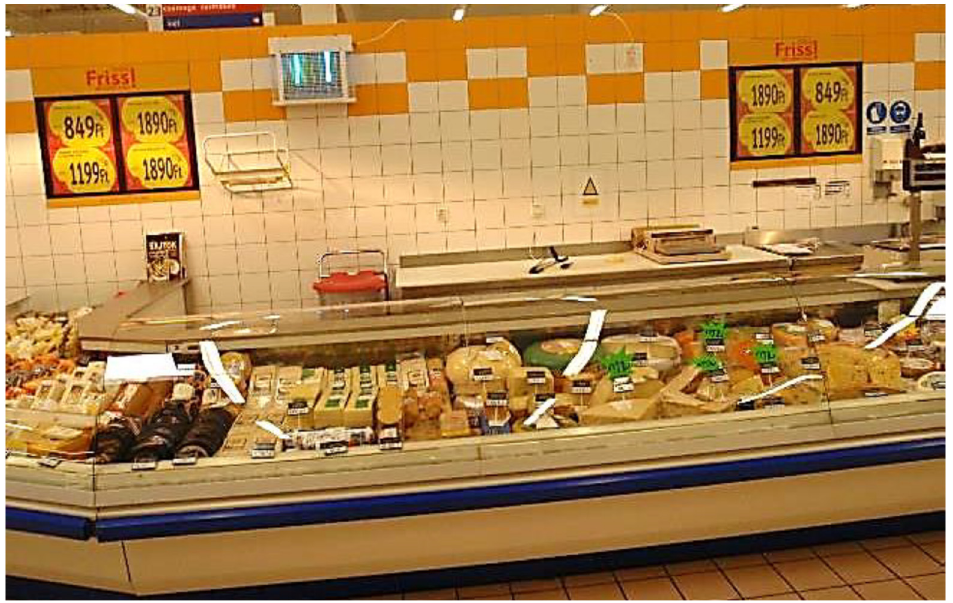
Figure 3. Supermarket meat and cheese counter with preparation area next to the wall and an electrocutor grid trap overhead, Budapest, Hungary.